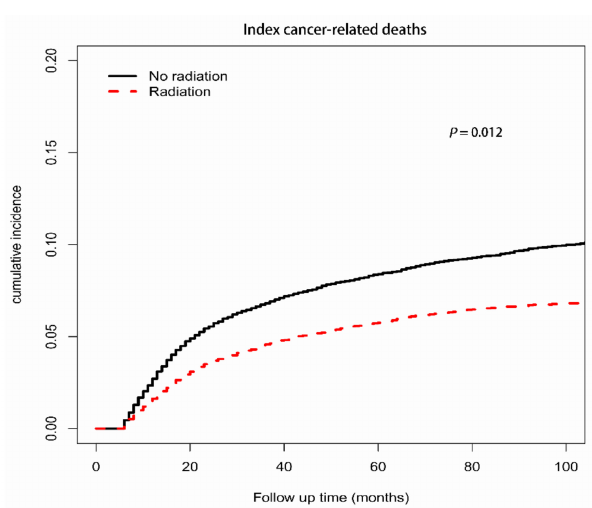
Figure 1. Cumulative incidence curves of death from index cancer among AYA patients, RT vs. no